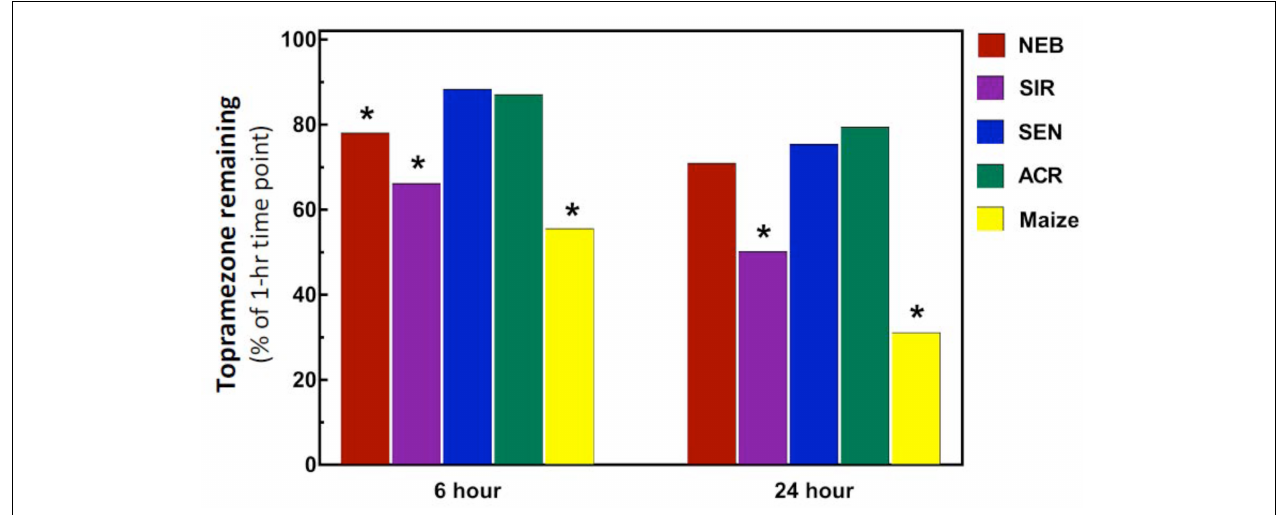
FIGURE 3 | Metabolism of topramezone in four waterhemp populations and maize 6 and 24 hours after treatment (HAT) using an excised leaf assay. Waterhemp and maize seedlings (10–12 cm tall) were grown in the greenhouse and transferred to a growth chamber 24-h before conducting the excised leaf assays, as described previously for mesotrione by Ma et al. (2013, 2015). Excised leaves were incubated for 1-h in a 150 µ M topramezone solution, then either harvested immediately or transferred to a dilute MS salts solution for the remainder of the time-course study. Relative concentrations of topramezone remaining in each excised leaf at 6 and 24 HAT (normalized to the average of the 1-h concentrations per population) are plotted on the Y -axis, which were determined with reverse-phase HPLC using pyrasulfotole as an internal standard as described in Section “Materials and Methods.” Treatment means significantly different ( α = 0.05) than the SEN population mean are marked with